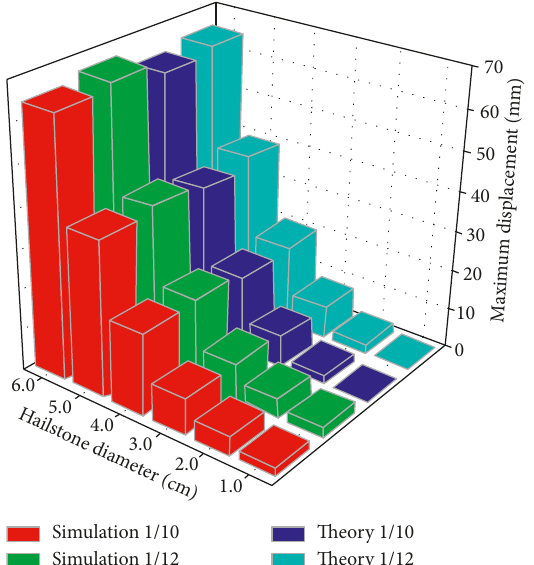
Figure 28: Comparison of impact point maximum displacement results between numerical simulations and theoretical